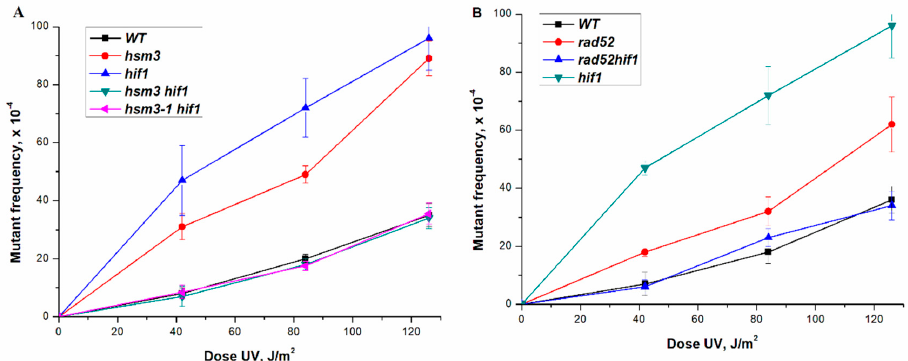
Figure 2. Dependence of the frequency of induced mutagenesis on the dose of UV rays. The mean ± SEM values obtained from 4 independent experiments are plotted. ( A ) Frequencies of UV-induced mutations in strain wild-type (LMG-3031) and mutant strains hsm3 Δ (5-LGM-3031), hif1 Δ (CAY-3), hsm3 Δ hif1 Δ (CAY-9), hsm3-1 hif1 Δ (TAE155); ( B ) Frequencies of UV-induced mutations in wild-type (LMG-3031) and mutant strains rad52 Δ (10-CAY-3031), rad52 Δ hif1 Δ (CAY-13), hif1 Δ (CAY-3).